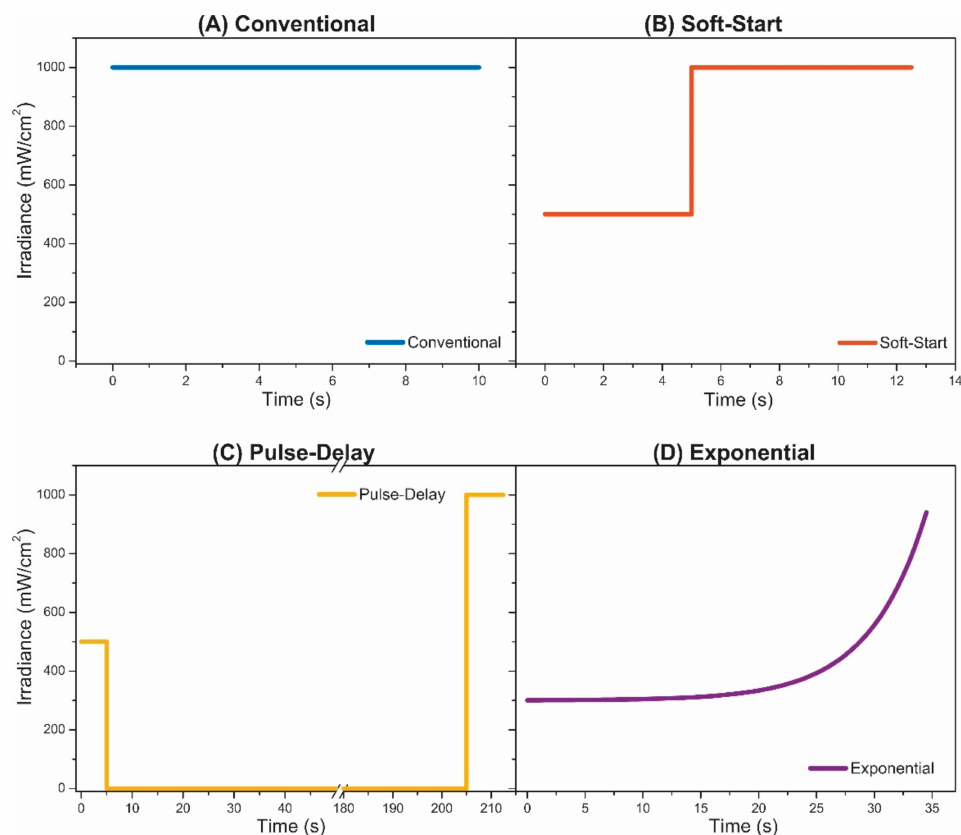
Figure 2. Representation of the irradiance variation as a function of time for the photoactivation protocols: ( A ) conventional, ( B ) soft-start, ( C ) pulse-delay and ( D )